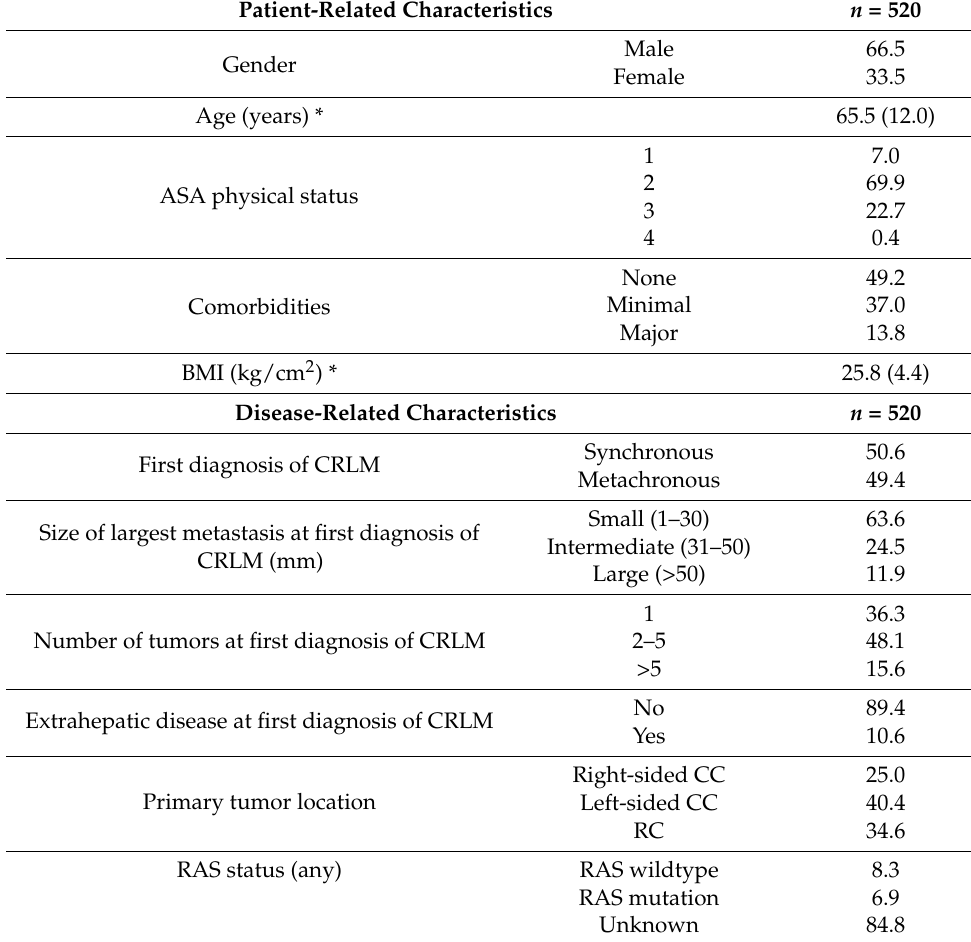
Table 1. Patient-, procedure-, and tumor-related characteristics.